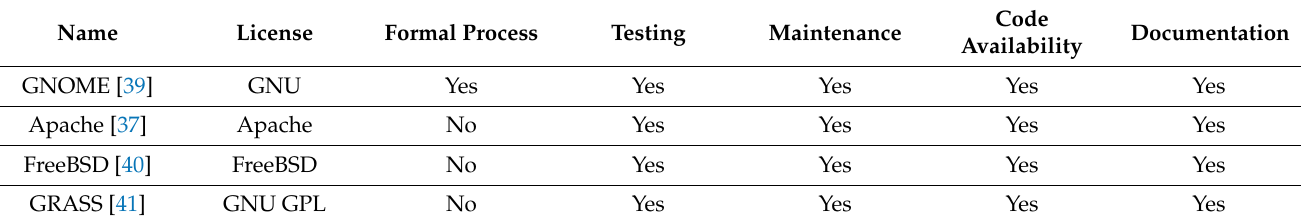
Table 3. A selected list of collaborative and open-source research using a collaborative